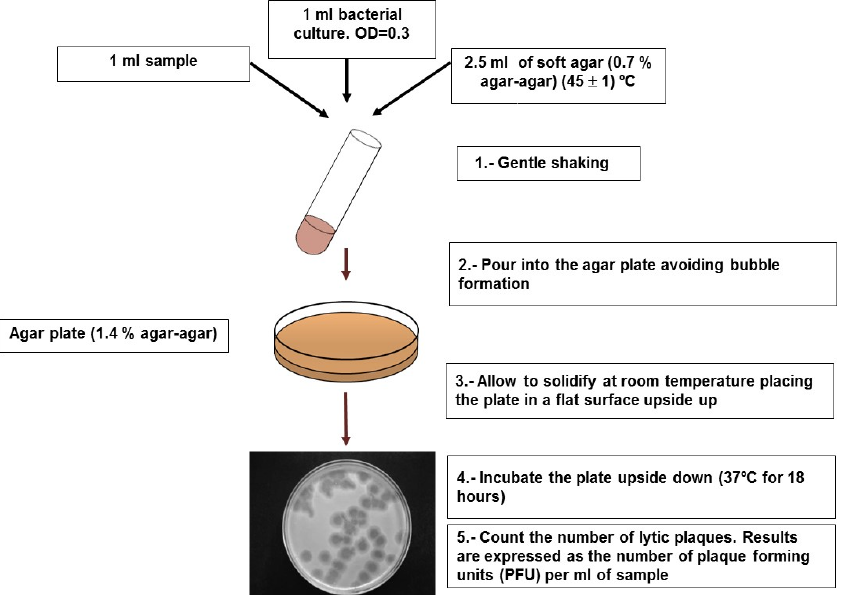
Figure 2. Double agar layer method for phage enumeration.